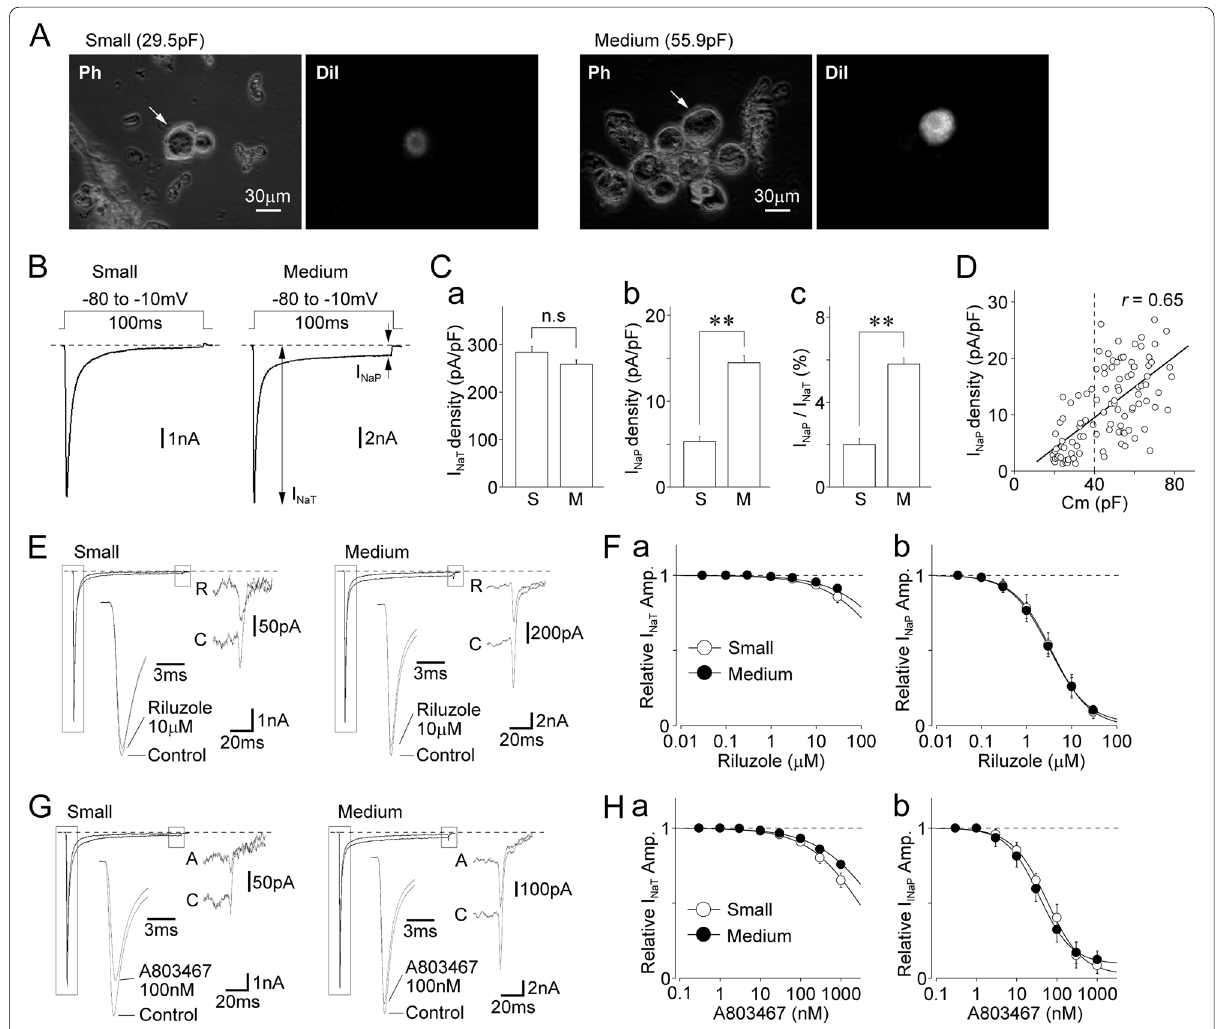
Fig. 1 Persistent sodium currents mediated by TTX‑R Na + channels in dural afferent neurons. A. Typical phase contrast (Ph) and fluorescence (DiI) images of small‑ (left) and medium‑sized (right) DiI‑positive neurons. B. Typical traces of TTX‑R I Na recorded in small‑ and medium‑sized DiI‑positive neurons. TTX‑R I Na was elicited by voltage step pulses (100 ms duration; ‑10 mV depolarization at a V H of ‑80 mV). The noninactivating persistent I Na (I NaP ) was followed by transient I Na (I NaT ) in DiI‑positive neurons. C. The mean values of the density of TTX‑R I NaT ( a ) and I NaP ( b ) and the amplitude ratio of I NaP /I NaT ( c ) in small‑ (S) and medium‑sized (M) DiI‑positive neurons. Columns and error bars represent the mean and SEM from 31 small‑ and 40 medium‑sized DiI‑positive neurons. **; p < 0.01, n.s; not significant (unpaired t‑test). D. Scatter plot of the density of TTX‑R I NaP against membrane capacitance (Cm) obtained from the same neurons ( n 71). The linear trend line represents the best fit using a least‑squares fit ( r 0.65). E. Typical = = traces of TTX‑R I Na recorded in the absence and presence of 10 μM riluzole in small‑ (left) and medium‑sized (right) DiI‑positive neurons. Inset traces show TTX‑R I NaT and I NaP with expanded time and amplitude scales, respectively. F. Concentration–response relationships of riluzole for TTX‑R I NaT ( a ) and I NaP ( b ). The points and error bars represent the mean and SEM from seven small‑ and seven medium‑sized DiI‑positive neurons. G. Typical traces of TTX‑R I Na recorded in the absence and presence of 100 nM A803467 in small‑ (left) and medium‑sized (right) DiI‑positive neurons. Inset traces show TTX‑R I NaT and I NaP with expanded time and amplitude scales, respectively. H. Concentration–response relationships of A803467 for TTX‑R I NaT ( a ) and I NaP ( b ). The points and error bars represent the mean and SEM from seven small‑ and seven medium‑sized DiI‑positive